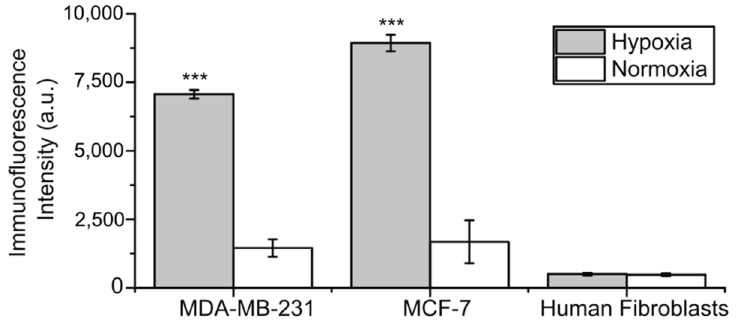
Figure 2. Fluorescence intensities calculated from CA IX immunofluorescence images of MDA-MB-231, MCF-7 cells, and human fibroblasts BJ-5ta under hypoxic as well as normoxic conditions (*** p < 0.001).